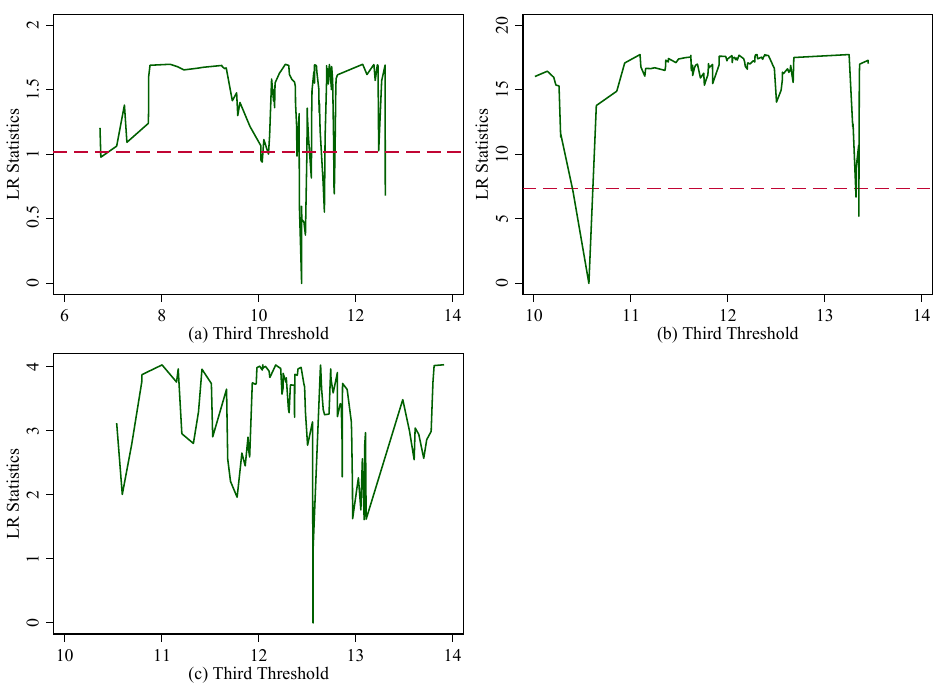
Figure 10. LR test results in different periods. Note: These graphs were created by the author using Stata 17.0. Notes: Figure ( a ) shows the LR test for the level of digital industrialization in the 11th Five-Year Plan period; Figure ( b ) shows the LR test for the level of digital industrialization in the 12th Five-Year Plan period; Figure ( c ) shows the LR test for the level of digital industrialization in the 13th Five-Year Plan period.